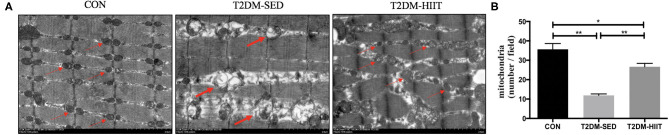
HIIT improves the mitochondrial morphology and density of skeletal muscle in T2DM mice. (A) Mitochondria morphological features, (B) The number of mitochondria. Thin arrows indicate normal mitochondria; bold arrows indicate damaged mitochondria. Scale bars, 2 μm. n = 3 per group; *p < 0.05, **p < 0.01.